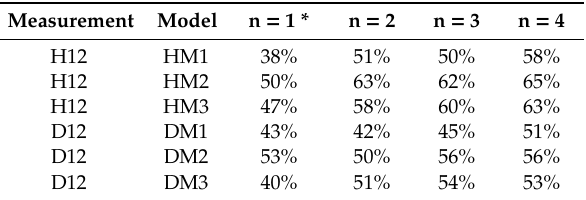
Table 5. Matching (%) between sets of genotypes selected from 32 full-sib families using measured and estimated values obtained using the indicated models (Set 2).